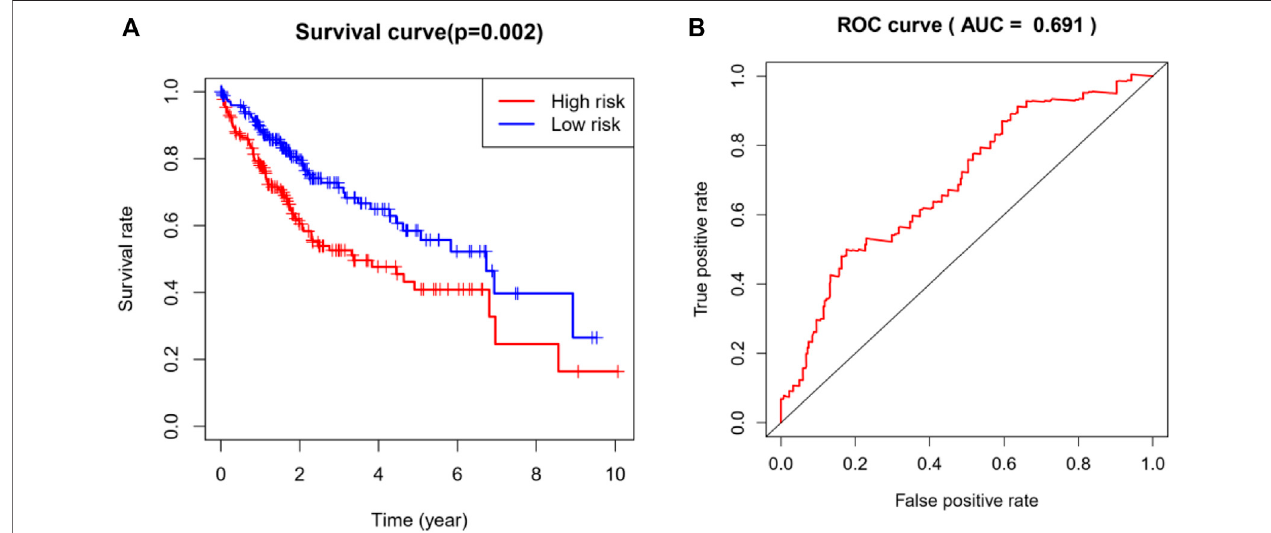
FIGURE6| Analysisandevaluation oftheriskprediction (diagnosis) modelsinHCC. (A) Kaplan-Meieranalysisdemonstratedthatpatientswithhigherriskshowed worsesurvivalrate( p (cid:1) 0.002). (B) TheAUCofROCcurve(AUC (cid:1) 0.69)showedthepredictiveaccuracyofTMBriskscores.AUC,areaundercurve;HCC,hepatocellular carcinoma; ROC, receiver operating